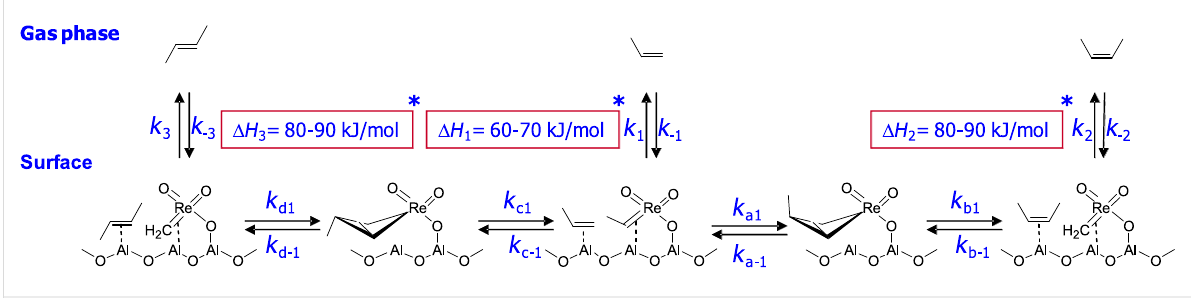
Scheme 4: Alkene selectivity of metathesis